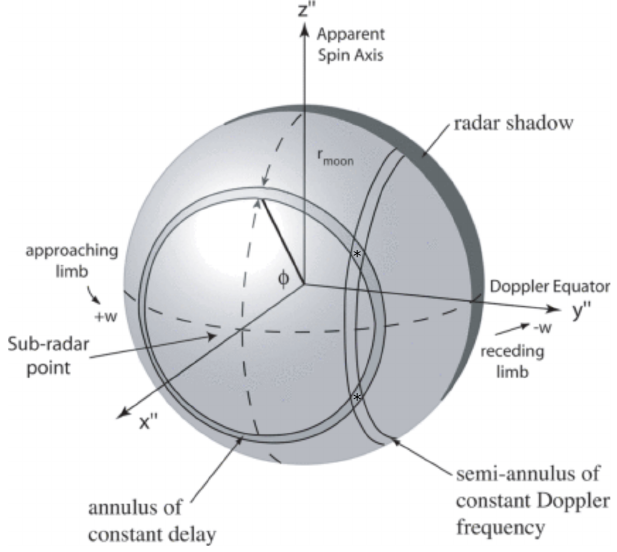
Figure 2. In this figure, the geometry of range–Doppler mapping is shown. Each range pixel takes the form of a ring on the surface of the Moon, centered on the sub-radar point. Each frequency bin takes the form of a ring, centered on the equator, 90 ◦ east and west of the sub-radar point. Marked with a star are two regions that will have the same range and Doppler dimensions and are symmetrical to the Doppler equator. These regions are indistinguishable with only range and Doppler information, and every point on the apparent northern hemisphere will have a point on the southern hemisphere with identical range and Doppler coordinates. Figure adapted from Campbell et al.